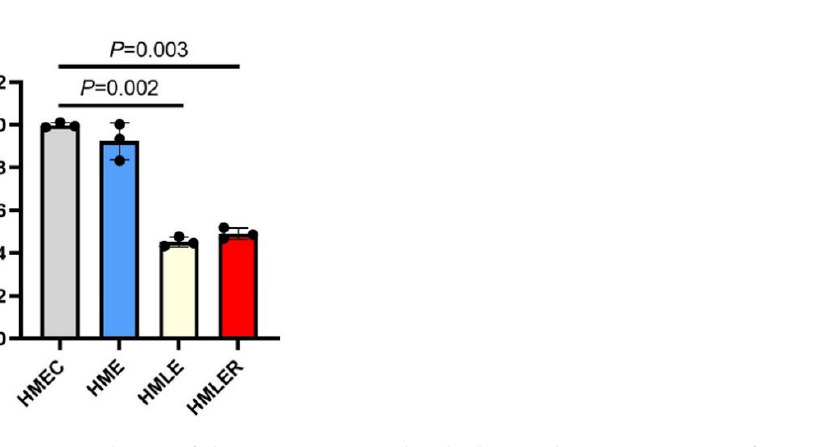
Figure 1. Downregulation of the HSPB2 mRNA levels during the oncogenic transformation of mammary epithelial cells. Relative HSPB2 mRNA expression levels in the genetically defined model of stepwise carcinogenesis consisting of HMEC (normal), HME, HMLE, and HMLER cells. Control HMEC cells were set to 1. GAPDH gene expression was used as a reference for RNA input. p -values were calculated using an unpaired t -test.